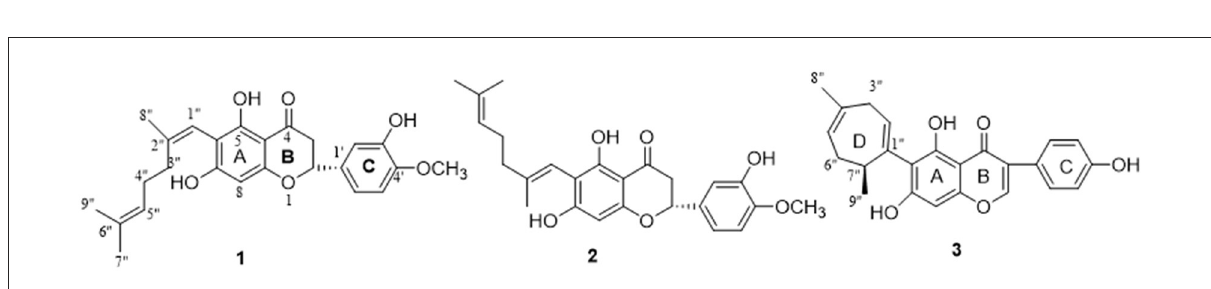
FIGURE2 Structures of new compounds 1 – 3